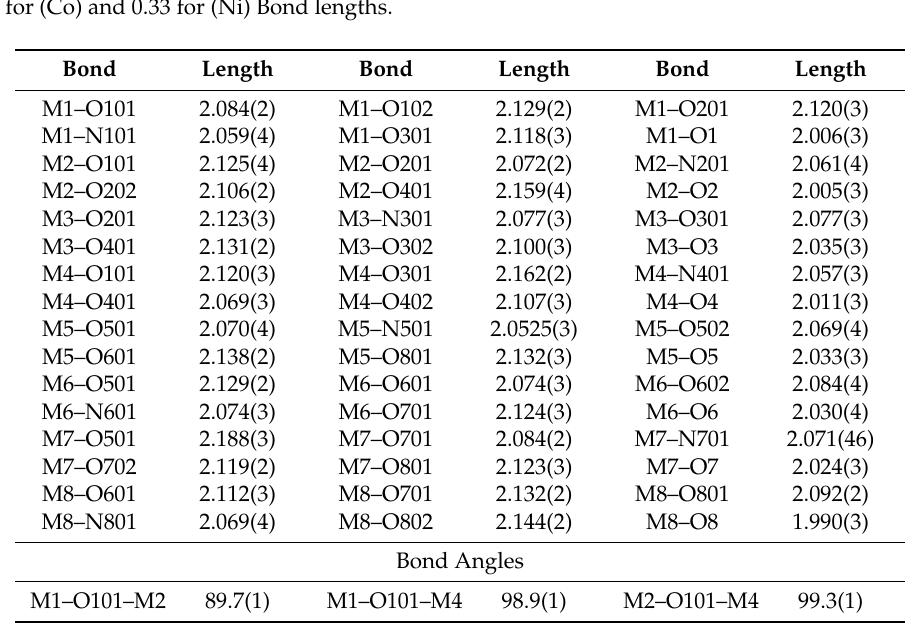
Figure 1. A single crystal structure of [M 4 L 4 (OAc ) 2 ] 2+ cationic units ( a ) A and ( b ) B of the title complex ( 1 ) with 50% probability thermal ellipsoids showing the atom labeling scheme. Shared position for metal ions are shown in green color. Hydrogen atoms are omitted for clarity; ( c ) crystal structure of a ligand HL. All hydrogen atoms are omitted except phenolic hydrogen. Table 2. Selected bond lengths (Å) and angles ( ° ) of ( 1 ) where site occupancy factors (s.o.f.) for M are 0.67 for (Co) and 0.33 for (Ni) Bond lengths.